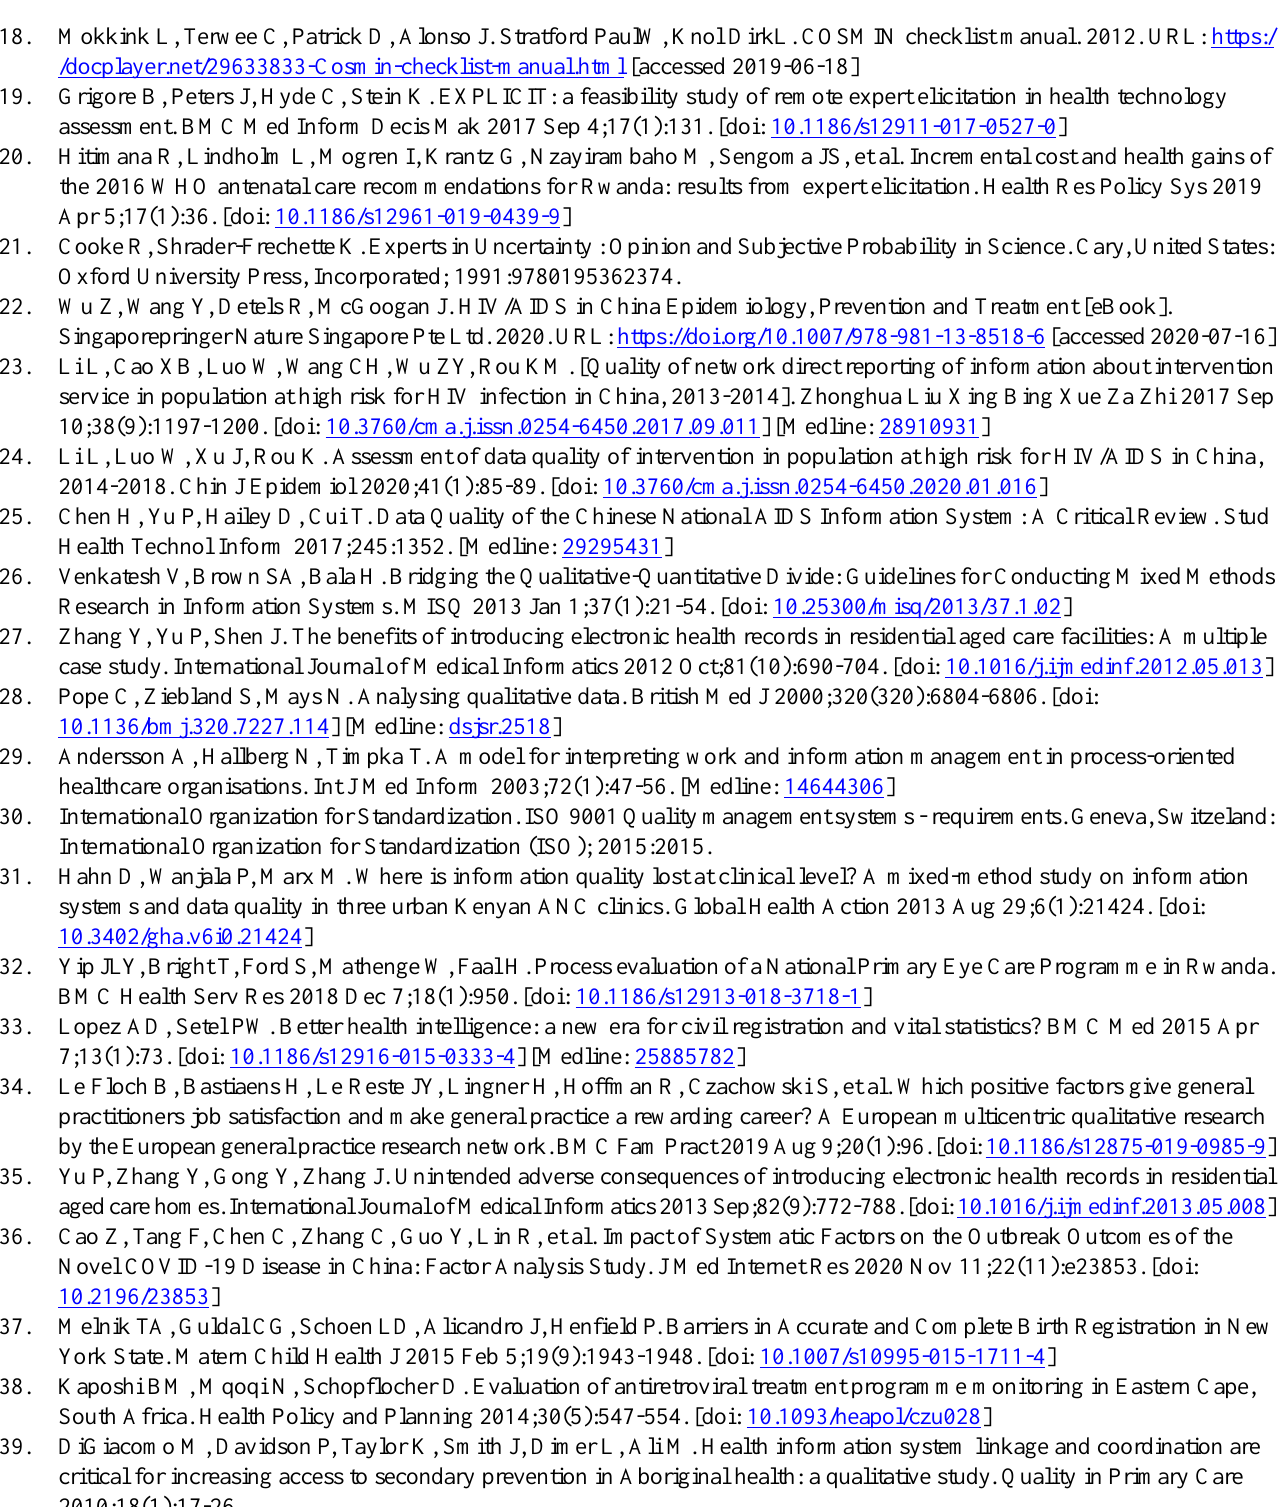
China CDC: Chinese Center for Disease Control and Prevention CRIMS: Comprehensive Response Information Management System ICT: information and communication